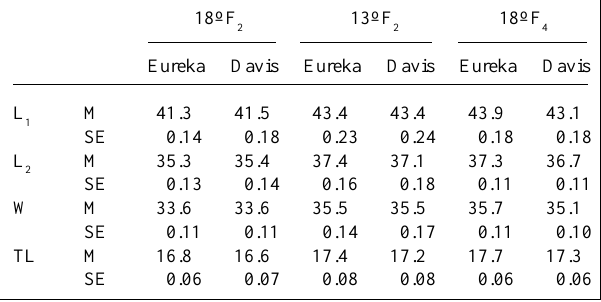
L1 and L2: Segments from the base of the fourth longitudinal vein to the posterior cross vein and from the posterior cross vein to the extreme of the media, respectively; W = wing width from the extreme of the V vein to the costal border, running perpendicular to the third vein; TL = tibial length.